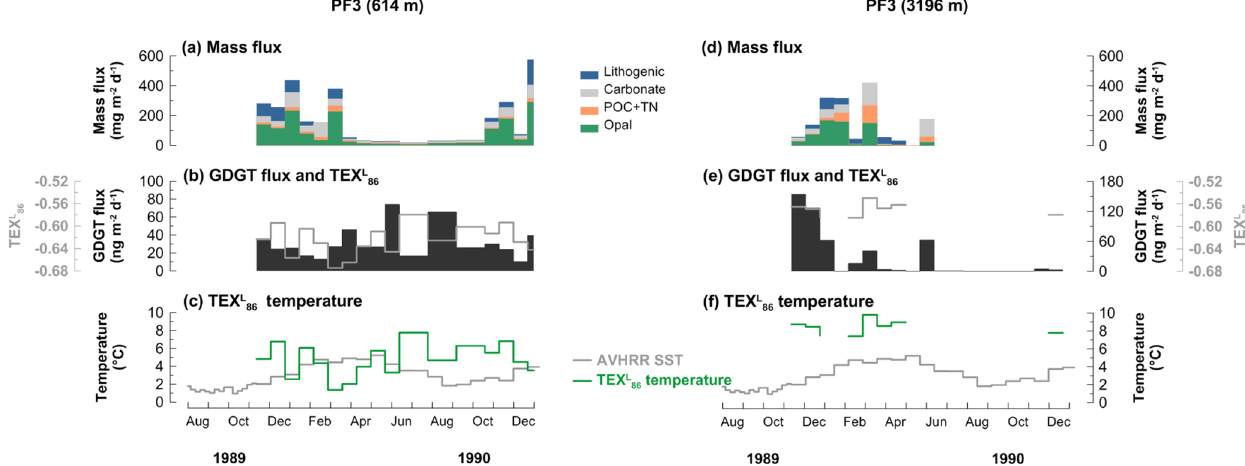
Figure 5. Changes in mass flux (a, d) , GDGT flux (b, e) , and TEX L -derived temperatures and satellite-derived SSTs obtained at 50.125 ◦ S, 86 5.875 ◦ E near the trap site (c, f) at the 614m (a, b, c) and 3196m (d, e, f) water depths at the Antarctic Polar Front site (PF3) during the deployment period (November 1989–December 1990).